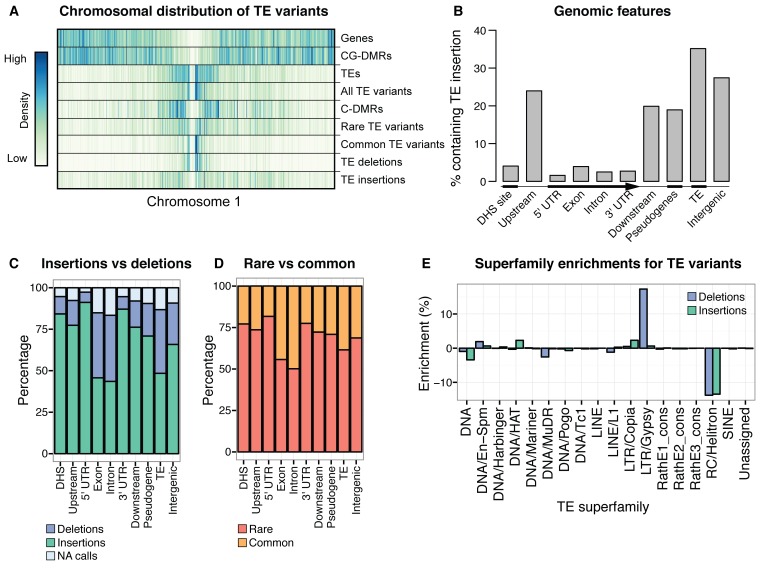
Extensive novel genetic diversity uncovered by TE variant analysis.(A) Distribution of identified TE variants on chromosome 1, with distributions of all Col-0 genes, Col-0 TEs, and population DMRs. (B) Proportion of different genomic features containing one or more TE variants. (C) Proportion of TE variants within each genomic feature classified as deletions or insertions. (D) Proportion of TE variants within each genomic feature classified as rare (<3% MAF) or common (≥3% MAF). (E) Enrichment and depletion of TE variants categorized by TE superfamily compared to the expected frequency due to genomic occurrence.DOI:
http://dx.doi.org/10.7554/eLife.20777.00810.7554/eLife.20777.009Figure 2—source data 1.TE presence variants in all 216 Arabidopsis accessions.List of all TE presence variants identified in the global population of 216 Arabidopsis accessions.DOI:
http://dx.doi.org/10.7554/eLife.20777.00910.7554/eLife.20777.010Figure 2—source data 2.TE absence variants in all 216 Arabidopsis accessions.List of all TE absence variants identified in the global population of 216 Arabidopsis accessions.DOI:
http://dx.doi.org/10.7554/eLife.20777.01010.7554/eLife.20777.011Figure 2—source data 3.All TE variants.List of all TE variants following insertion/deletion classifications based on minor allele frequencies.DOI:
http://dx.doi.org/10.7554/eLife.20777.01110.7554/eLife.20777.012Figure 2—source data 4.TE family enrichments for TE insertion and TE deletion variants.Observed versus expected number of TE insertions and TE deletions for each TE family.